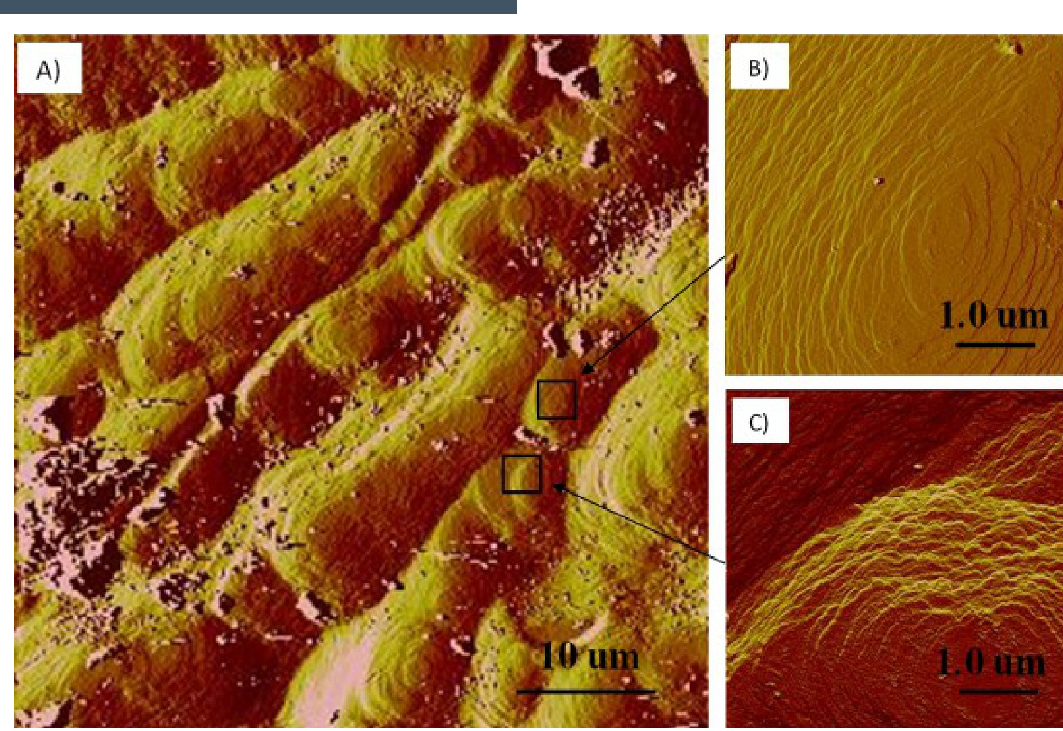
Figure 3. Zn-doped PETN crystal with multiple two-dimensional dislocations; the zoomed areas (B and C) show layer-by-layer growth.